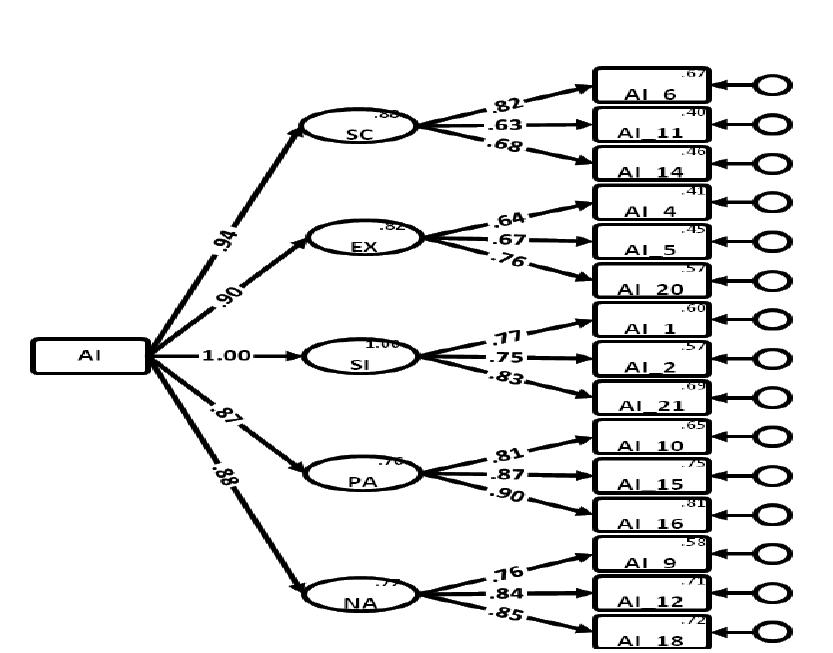
Figure 1 . Model of Aims-plus with factor loadings ( n